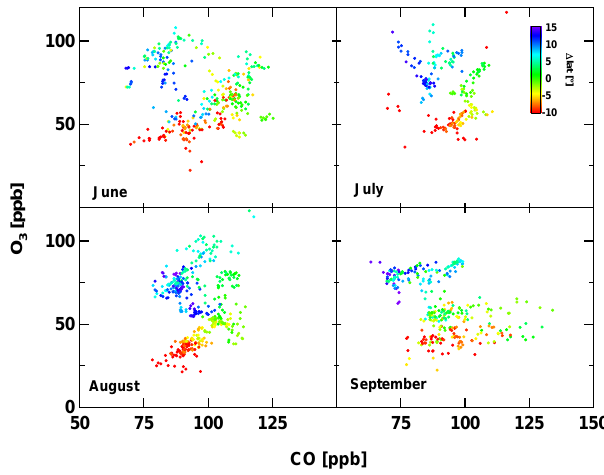
Figure 7. Monthly distributions of O 3 vs. CO during the summer monsoon season 2008. Points are colour-coded by relative position within the UTAC, as determined by (cid:49) lat (see also Sect. S6 in the